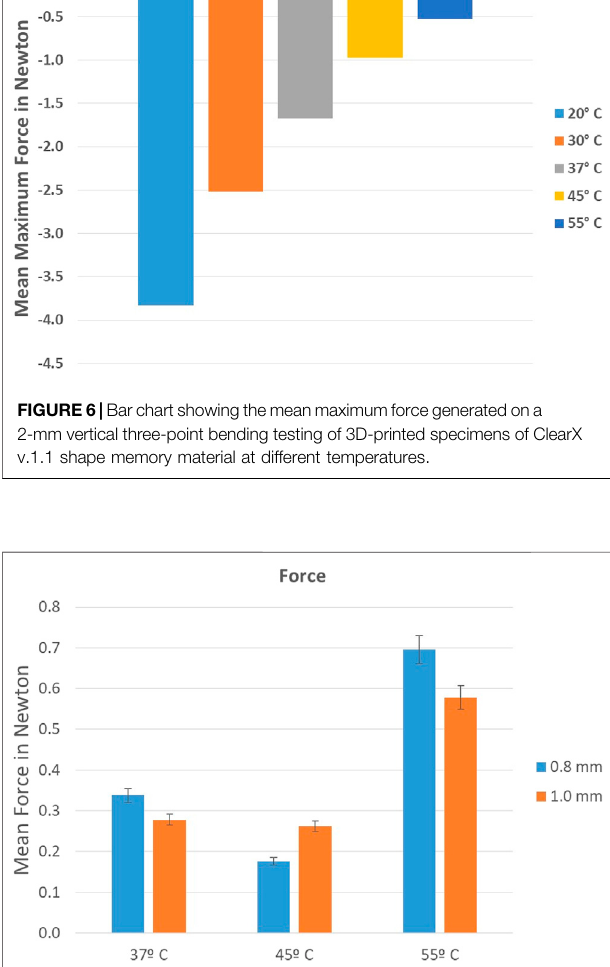
FIGURE 7 | Bar chart showing forces generated by 4D-printed aligners oftwodifferentthicknesses;measurementwasdoneatdifferenttemperatures in a custom-made biomechanical system